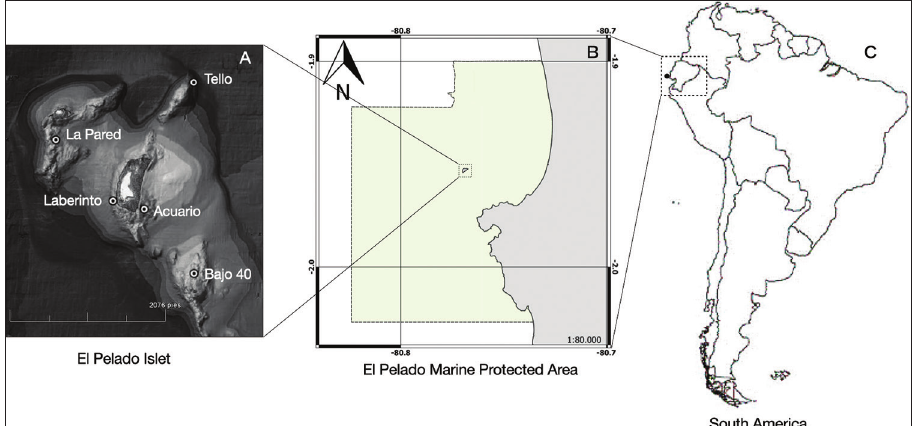
Figure 1. Map of the Marine Protected Area El Pelado A The Pelado islet and its submarine platform with five sampling locations of the sponges B map of the whole Marine Protected Area El Pelado at the Ecuado- rian coast C map of South America highlighting Ecuador ( map created using QGIS software Version